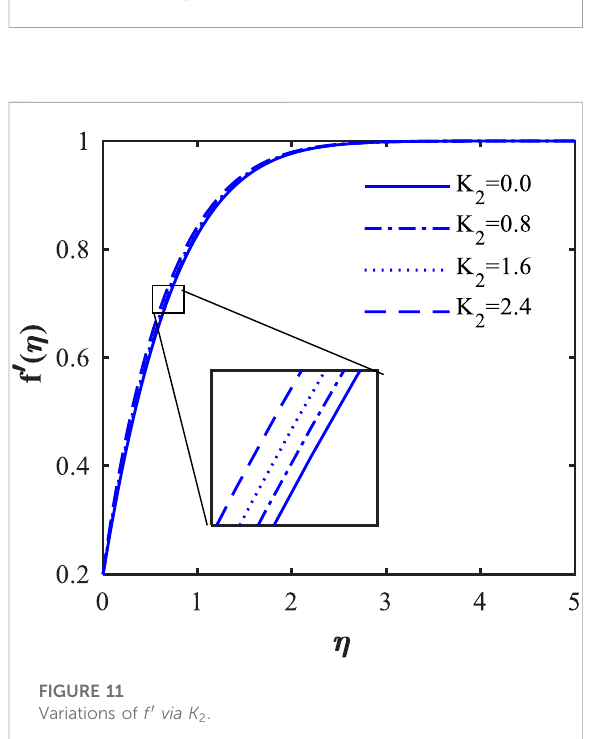
FIGURE 10 Variations of ϕ via β .